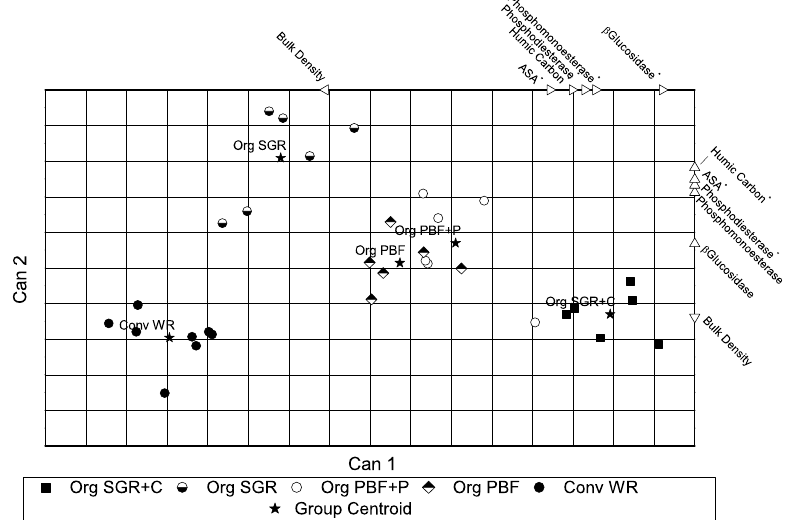
Figure 1. Canonical discriminant analysis scatter plot showing the separation of samples from the different plots. Additional axes show the most important variables contributing to the formation of the canonical variables. The extension of each arrow from the plot center indicates the importance of the variable in the canonical structure according to Pearson correlation coefficients and its direction reports the increase or decrease of the variable. Stars indicate centroid of each cloud.